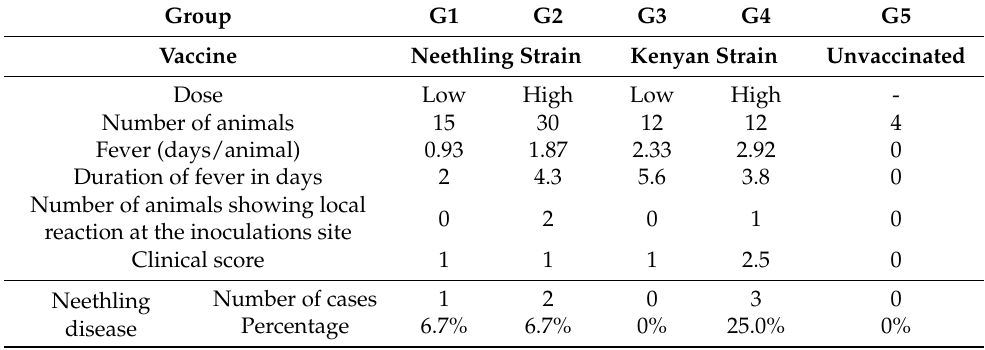
Figure 3. Average temperature of animals of G1 vaccinated with low dose of Neethling strain, G2 vaccinated with high dose of Neethling strain, G3 vaccinated with low dose of Kenyan strain, and G4 vaccinated with high dose of Kenya strain. Table 3. Clinical scoring in animals vaccinated with Neethling t and Kenyan strains at different doses.